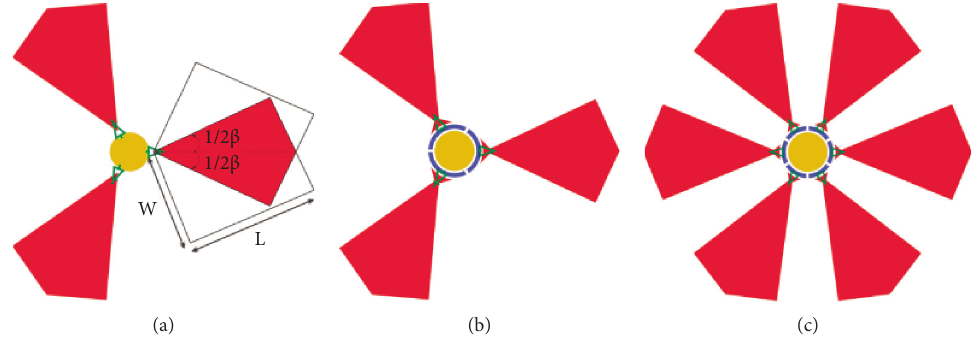
Figure 1: The antenna design evolution: (a) Ant. 1, (b) Ant. 2, and (c) Ant.